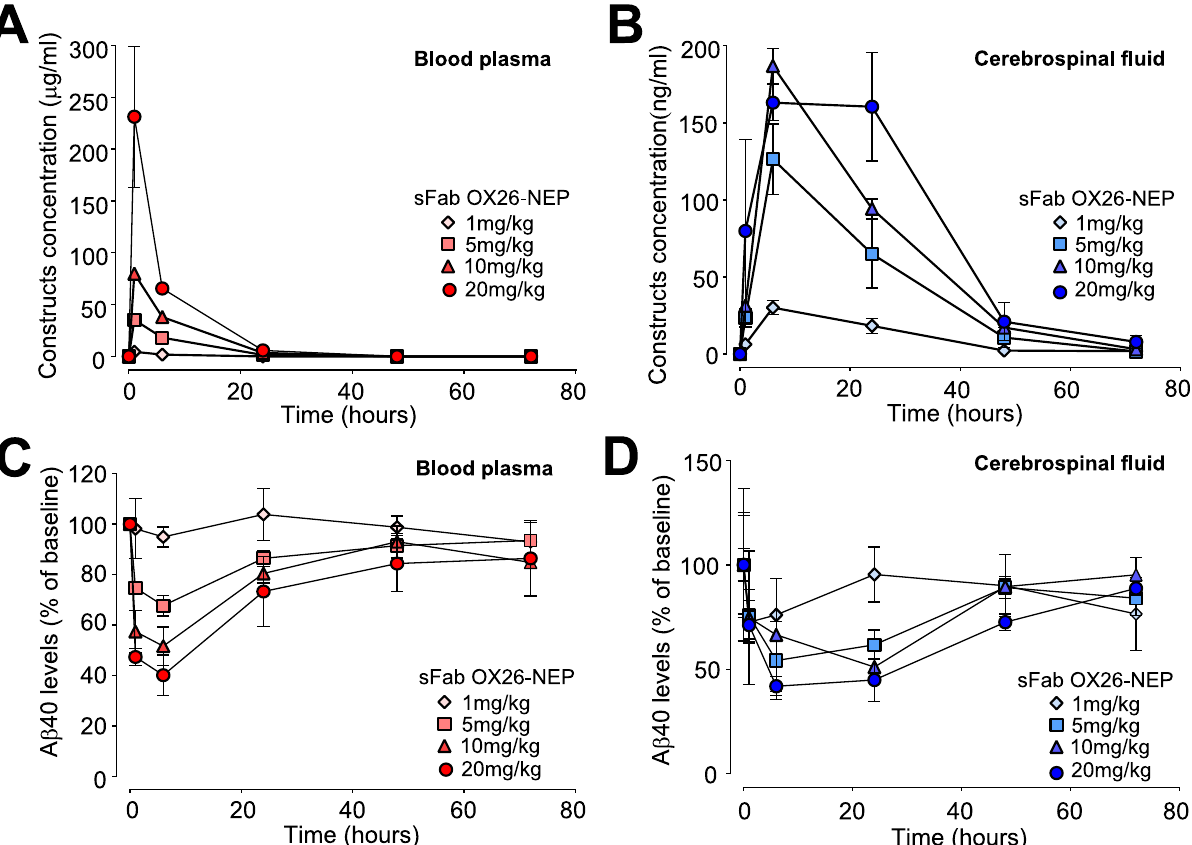
Fig 3. Dose dependent A β 40 reduction in plasma and CSF. Single i.v. administration of 1 mg/kg (diamonds), 5mg/kg (squares), 10mg/kg (triangles) and 20mg/kg (circles) sFab OX26-NEP construct in cisterna magna cannulated rats. (A & B) Construct‘s concentrations and (C & D) A β 40 levels measured in blood plasma (red symbols) and CSF (blue symbols) over